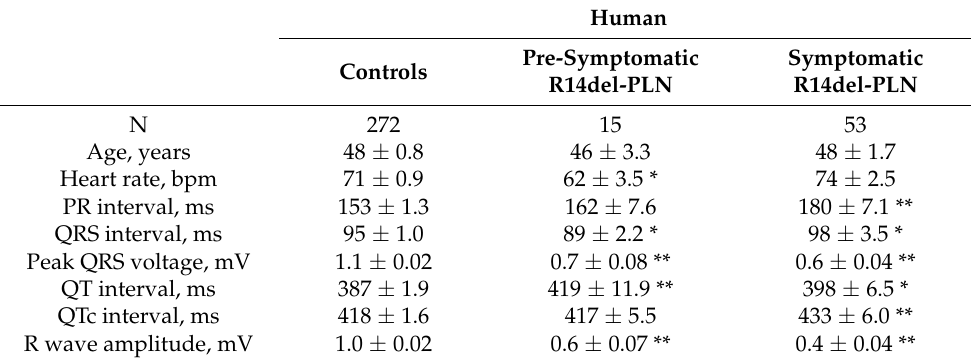
Table 2. ECG characteristics of pre-symptomatic and symptomatic R14del-PLN mutation carriers and their age and sex-matched